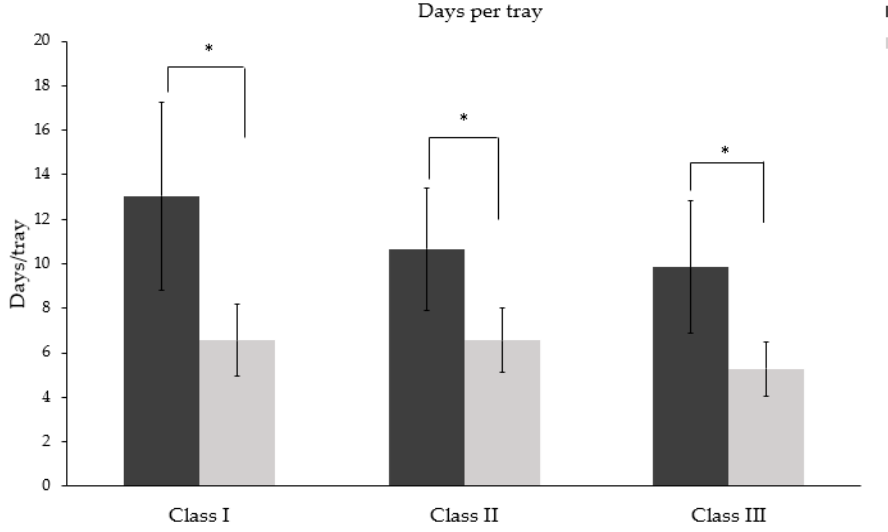
Figure 2. Average number of days per tray/aligner in the control and LIPUS treated group (* p < 0.05).